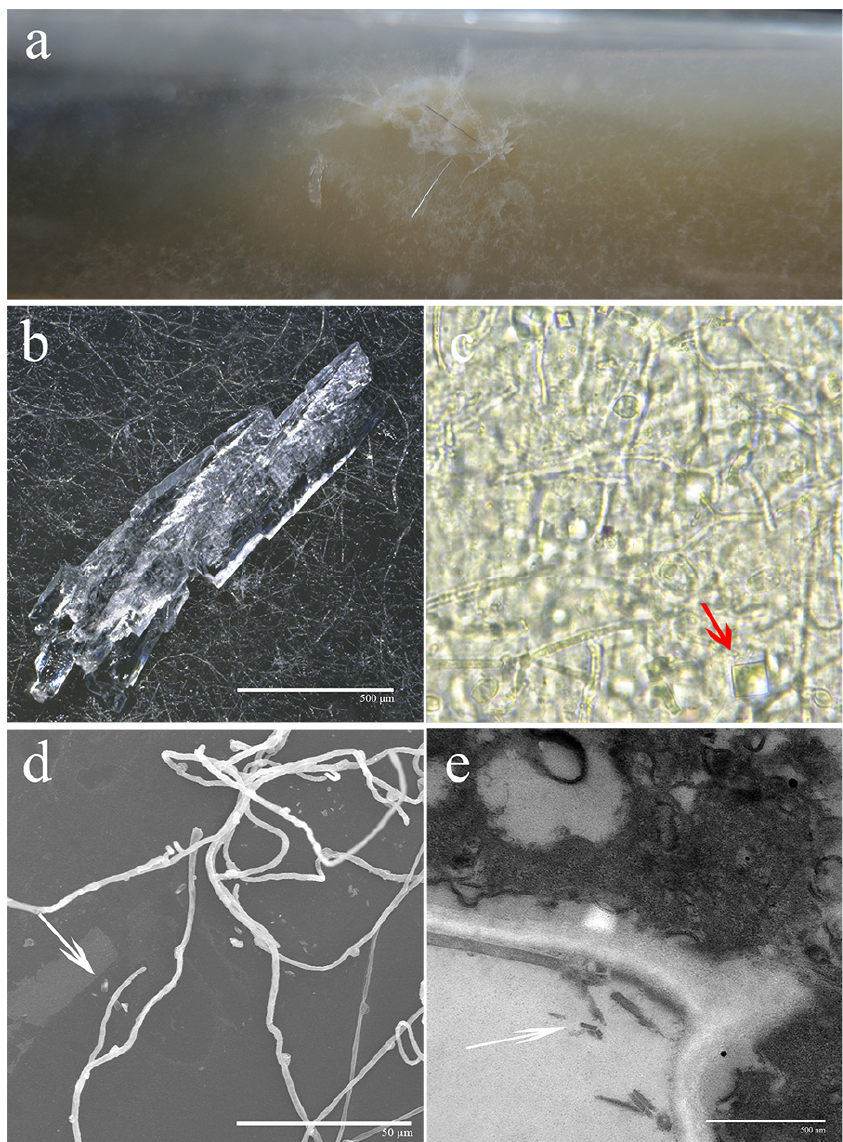
Figure 1. Morphological characterization of mycelium and crystals. The macroscopic morphology and microstructures were observed simultaneously using ( a ) a digital camera, ( b ) 3D digital microscopy, ( c ) light microscopy, ( d ) SEM, and ( e ) TEM. Crystals are indicated with red and white arrowheads.